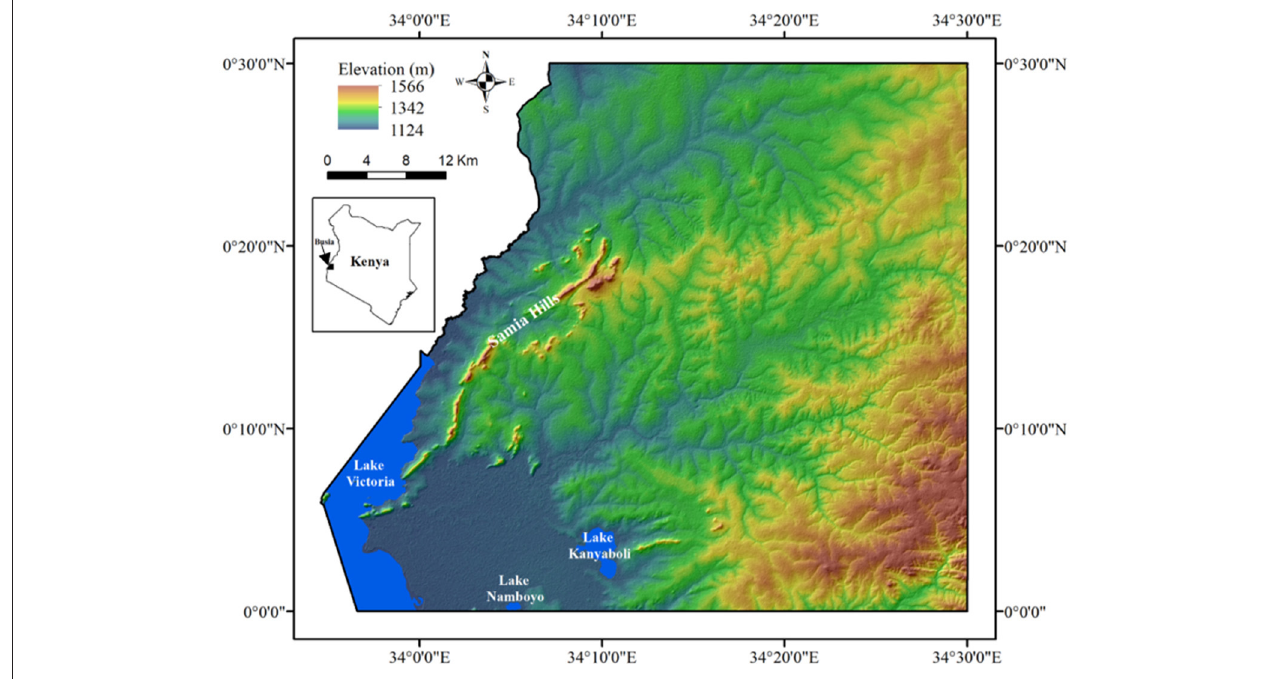
FIGURE 2 | Geographic location of the Busia